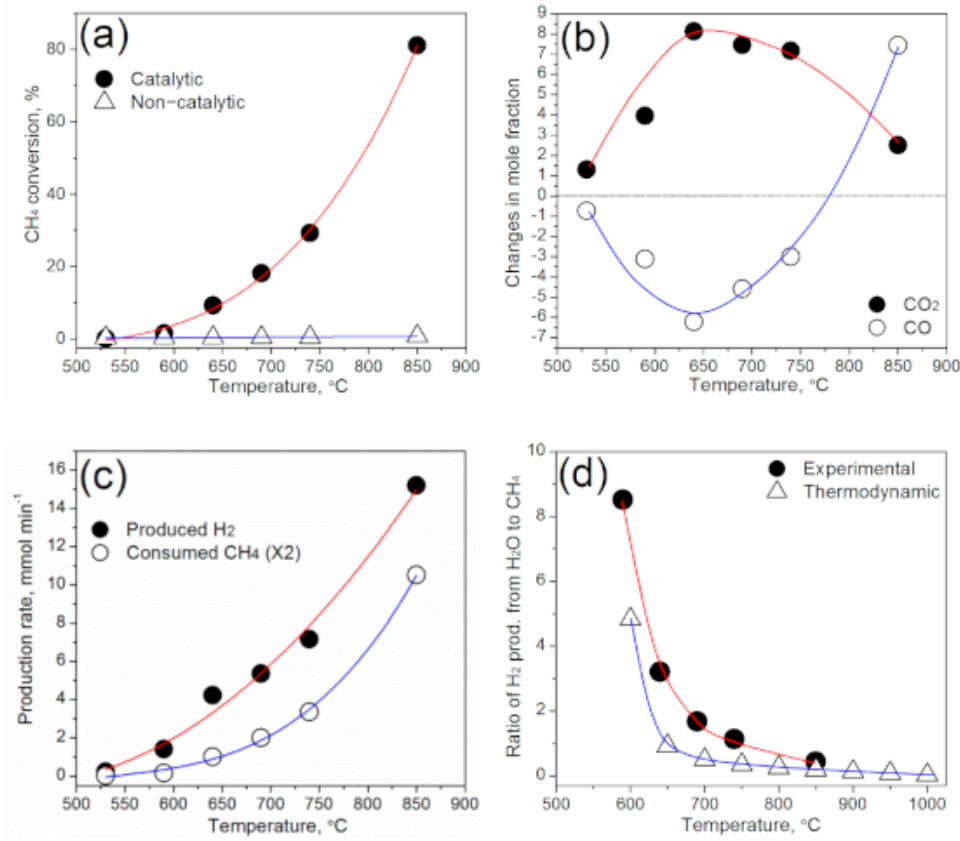
Figure 3. Changes in the steam-CO 2 reforming (SCR) of bio-syngas as a function of temperature at GHSV (Gas hourly space velocity) of 7.6 × 10 4 h − 1 , 40 vol % steam and 1 wt % Rh/Al 2 O 3 monolith (Steam/CH 4 = 5.8). ( a ) Comparison in methane conversion between catalytic and non-catalytic (i.e., blank) run; ( b ) Changes in the molar fraction of CO and CO 2 ; ( c ) Comparison the produced hydrogen against consumed methane ( × 2); ( d ) Comparison in contribution of steam and methane to hydrogen production between experimental outcome and thermodynamic calculation in this